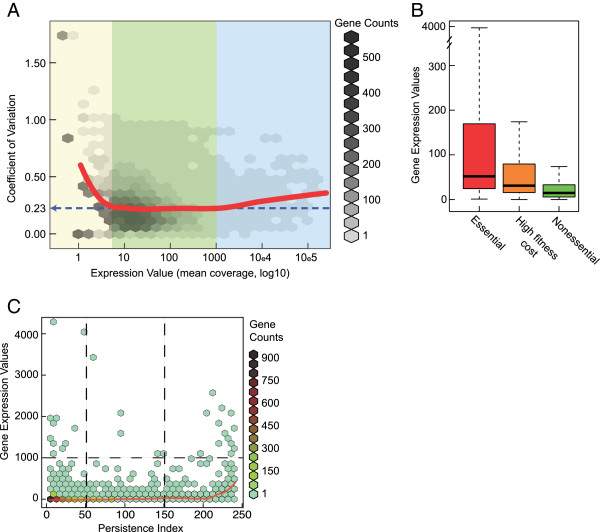
Relationship between gene expression, essentiality and persistence. (A) Genes are classified into three groups based on their expression levels and CV. Here data from 5 cell cycle time points were pooled for the analysis of gene expression and CV from 3 replicates. The background hexbin density plot describes the relationship between CV and expression values for all genes. The red curve is a local regression of CV values as a function of expression (using the LOESS R package). Based on this fitting, genes are classified into three groups indicated by different colors. Most genes fall into the group in the middle, where their average CV remains constant at 0.23 (the blue dotted arrow). The group on the left has, on average, high CV, and shows negative correlation between CV and expression. This group is suggested to include background transcription noise. The group on the right consisting of highly expressed genes also shows significantly higher CV. (B) Gene expression versus essentiality. Box and whisker plot of expressions grouped by essential, high-fitness-cost and nonessential genes. (C) Hexbin plot showing genes expression versus persistence. The red trend curve is a local regression of median expression versus PI (LOESS R package). The horizontal bar distinguishes the highly expressed genes (>1,000x) from the others, whereas the vertical bars delineates less conserved (PI < 50) genes from persistent (PI >150) genes.